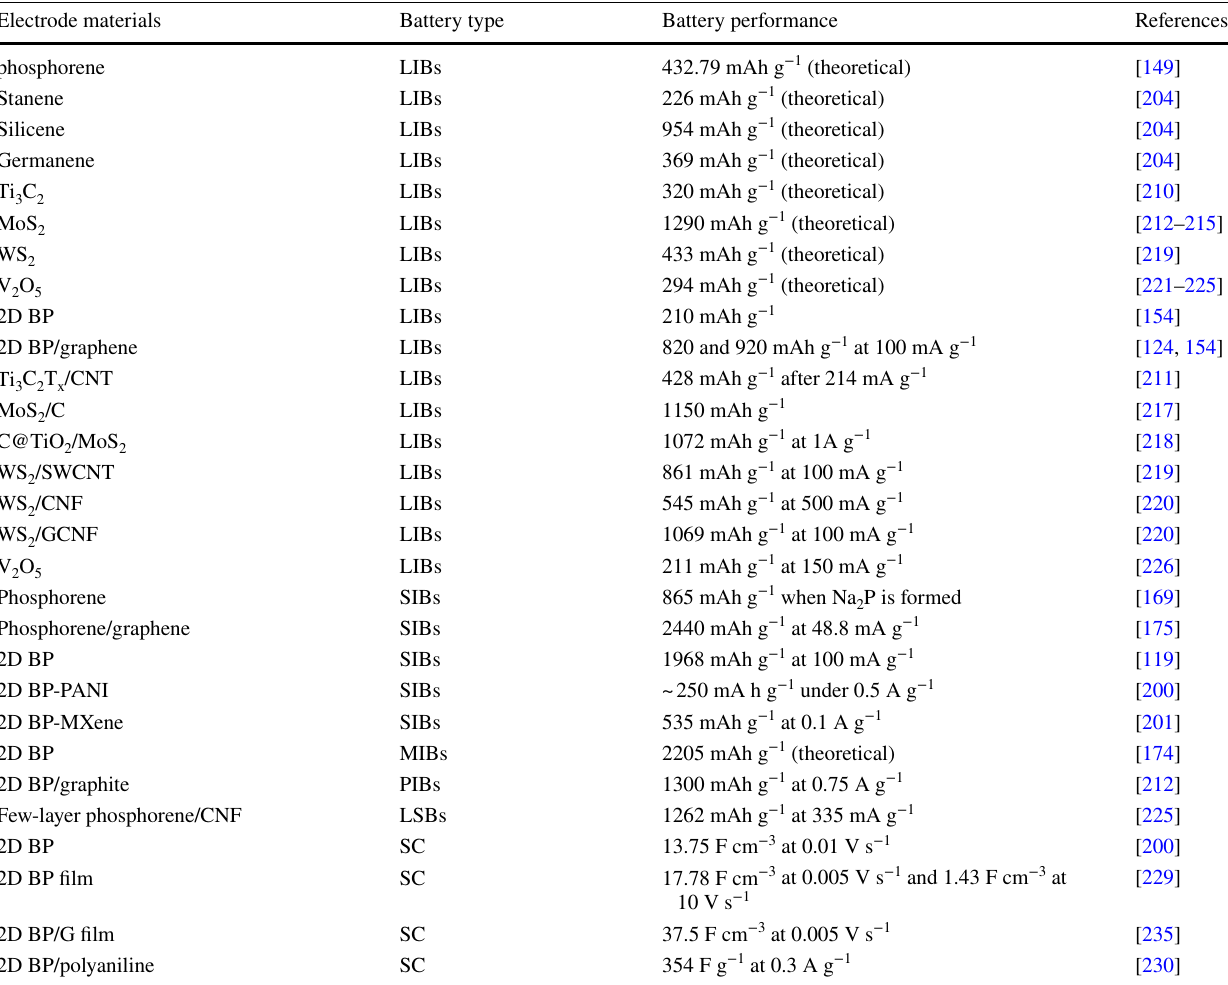
Table 3 Summary of energy storage performances of 2D BP and other 2D materials Electrode materials Battery